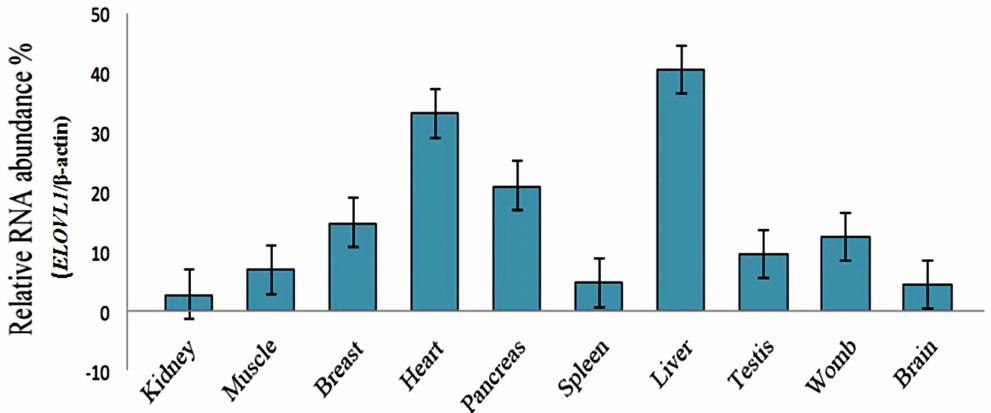
Figure 4. Tissue distribution of ELOVL1 transcripts. ELOVL1 mRNA was analyzed